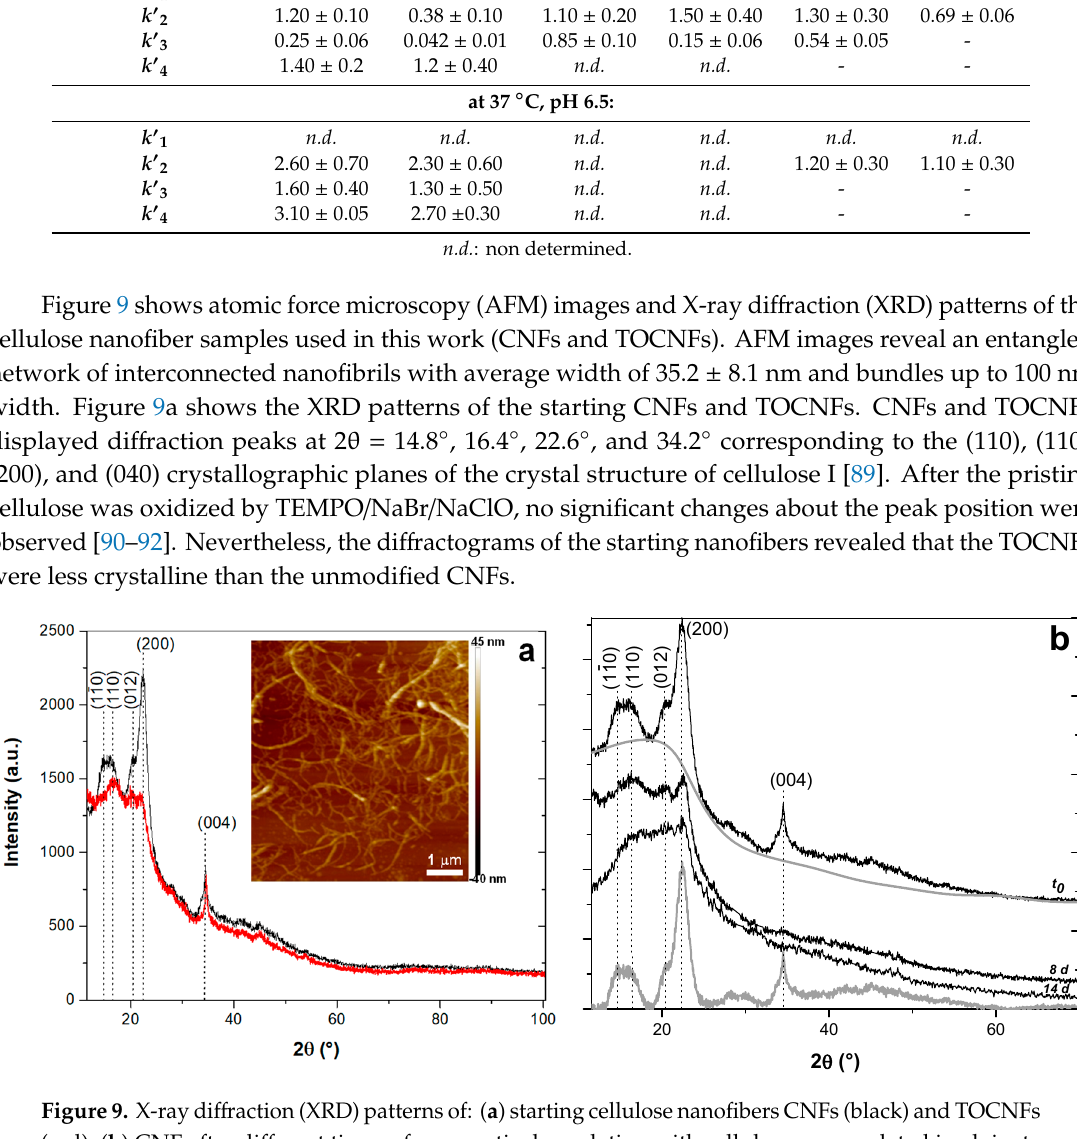
Figure 9. X-ray di ff raction (XRD) patterns of: ( a ) starting cellulose nanofibers CNFs (black) and TOCNFs (red); ( b ) CNF after di ff erent times of enzymatic degradation with cellulase encapsulated in alginate microparticles. Grey curves in ( b ) show the separated crystalline peaks of the CNF di ff ractogram obtained by subtracting the amorphous contribution which was estimated by applying a cubic B-spline (also in grey) for curve fitting. The XRD patterns at the di ff erent times were vertically shifted for clarity. Inset in ( a ): AFM topography of the CNFs nanofibril